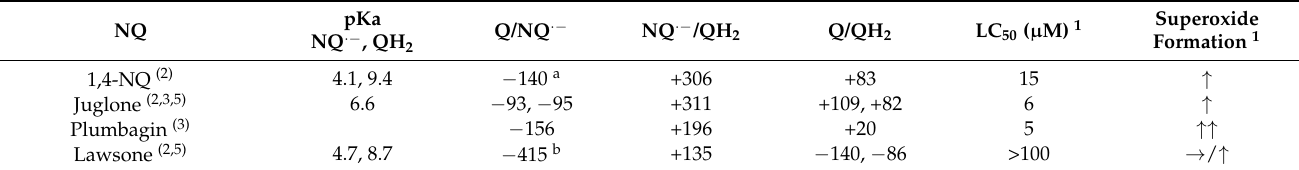
Table 2. Reduction potentials and relative toxicity (LC 50 ) of naphthoquinones used in this